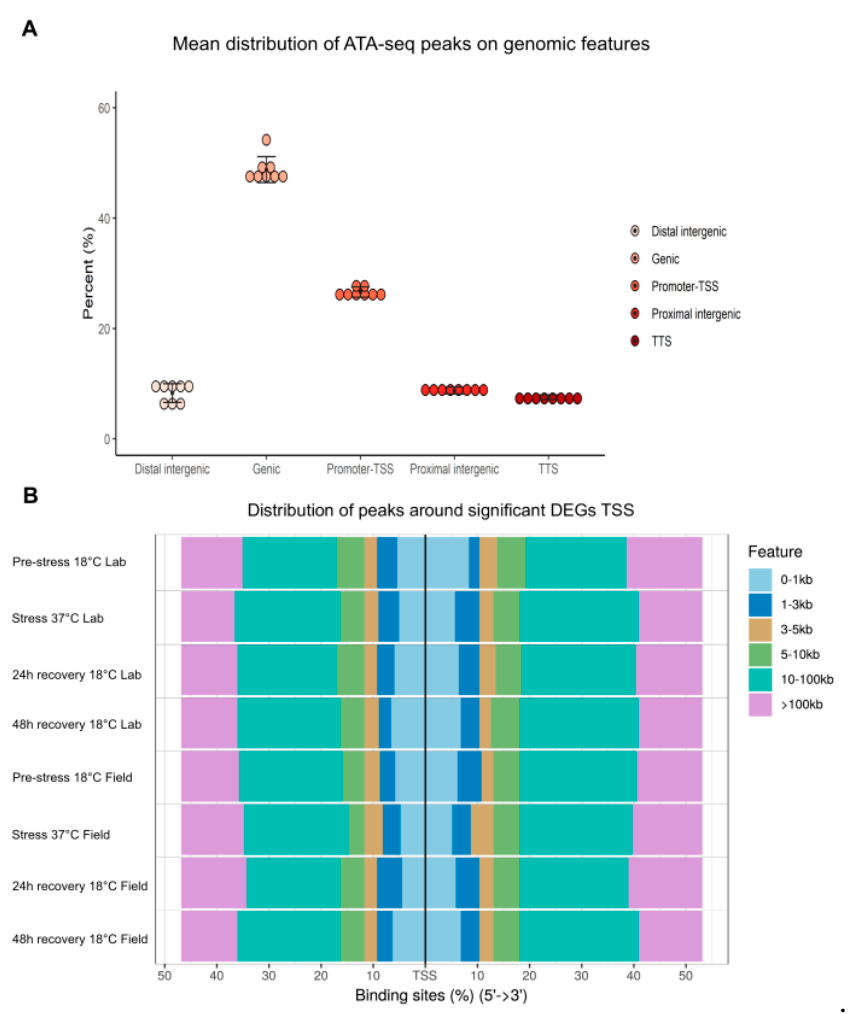
Figure 2. Peak distribution. ( A ) The average percentage of genomic features of field and lab N. vectensis calculated from all ATAC-seq libraries and sampling points ( n = 24)—replicates were joined into one group average. Genomic features are: Genic—all ATAC-seq sites that are within the gene body (intron or exon), Promoter-TSS (Transcription Start Site)—all ATAC-seq sites that are within promoter limits (1500 bp downstream of the TSS), TTS (Transcription Termination Site)—all ATAC-seq sites that are within 500 bp upstream of the TTS, Proximal intergenic—all ATAC-seq sites that are within 1001 bp to 5000 bp downstream of the TSS or 501 bp to 5000 bp upstream of the TTS, Distal intergenic—all ATAC-seq sites that are more than 5001 upstream of the TTS or more than 5001 upstream of the TSS. ( B ) Distribution of ATAC-seq peaks around DE genes of each group.